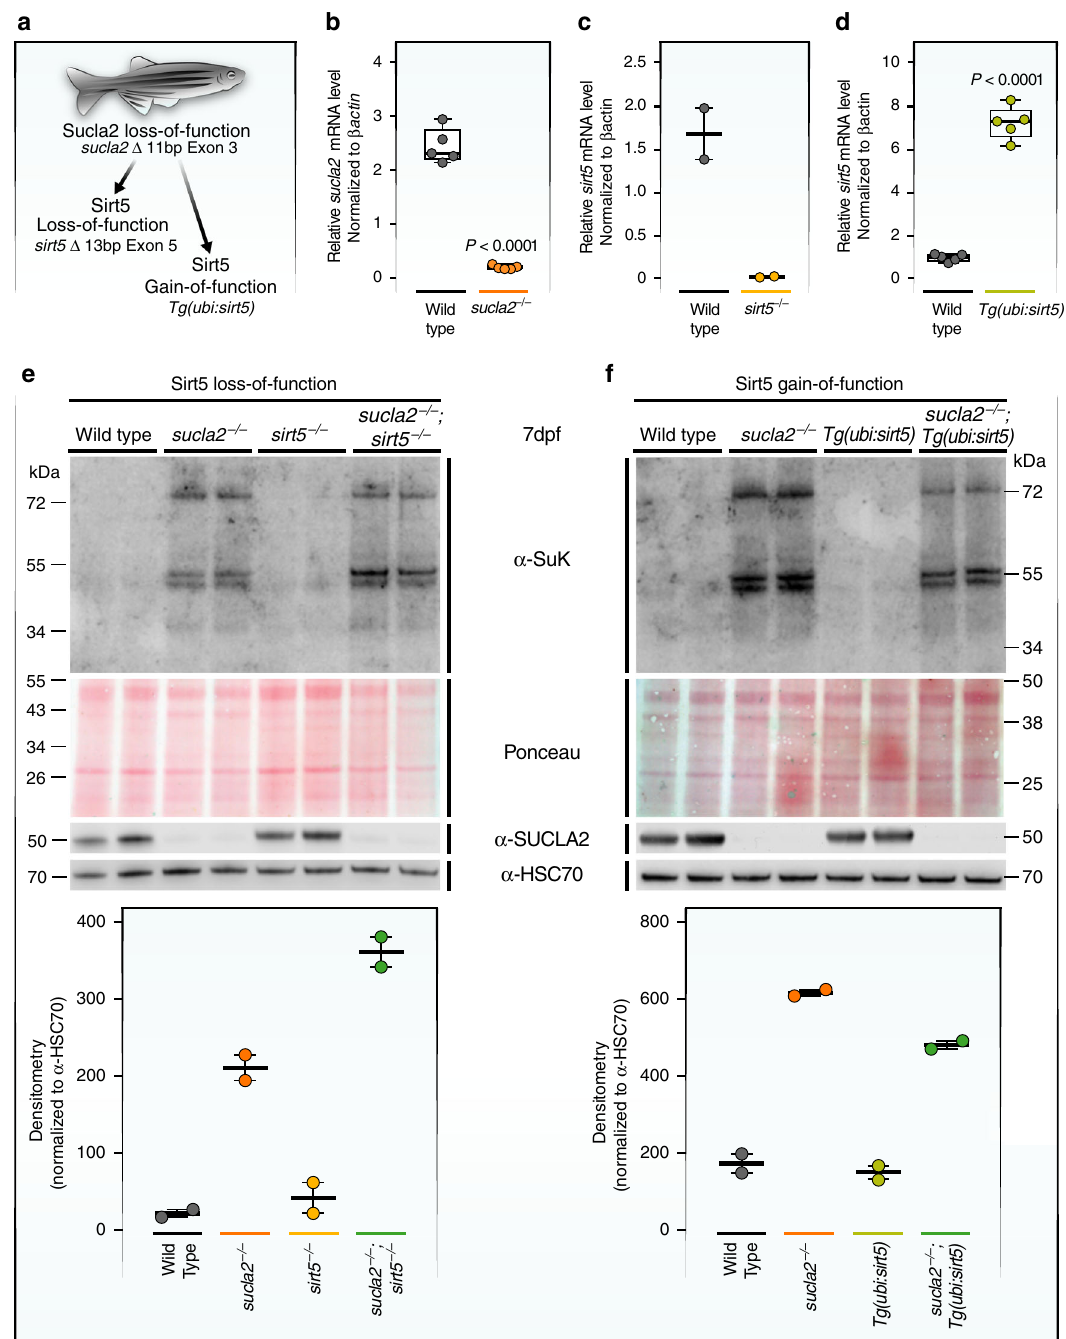
Fig. 4 Sirt5 modulates global protein succinylation in a zebra fi sh model of SCL de fi ciency. a Schematic representation of genetic backgrounds used for zebra fi sh experiments. b Relative sucla2 mRNA levels in sucla2 − / − zebra fi sh ( n = 5 pools of 6 larvae, 7 dpf). c Relative sirt5 mRNA levels in sirt5 − / − zebra fi sh ( n = 2 tissue samples from adult skeletal muscle, adults of 3 months). d Relative sirt5 mRNA expression in Tg(ubi:sirt5;cryaa:zsgreen) transgenic zebra fi sh ( n = 5 pools of 8 larvae, 8 dpf). All data in b – d , compared to wild-type siblings and normalized to β actin mRNA levels. p -values are calculated by standard unpaired t -tests for b and d . e SDS-page and western blot analysis of global protein succinylation in zebra fi sh larvae with homozygous mutations in sucla2 , sirt5 , or combined gene de fi ciencies and controls (7 dpf, n = 2 pools of 10 – 15 larvae) and f Pan-succinyl-lysine western blots of samples from larvae overexpressing sirt5 in wild-type or sucla2 − / − animals ( n = 2 pools of 10 to15 larvae, 7dpf). Pan-succinyl-lysine antibodies were used to quantify lysine succinylation, and Hsc70 antibodies were used as loading controls. Ponceau staining serves as an additional loading control. Boxplots in e , f show quanti fi cations of western blots using the mean of the densitometry of the three main bands, normalized to Hsc70. The boxplots show the median, the fi rst to third quartile, and minima and maxima. Western blot images are derived from a single experiments. Source data are provided as a Source Data fi le. Bp = base